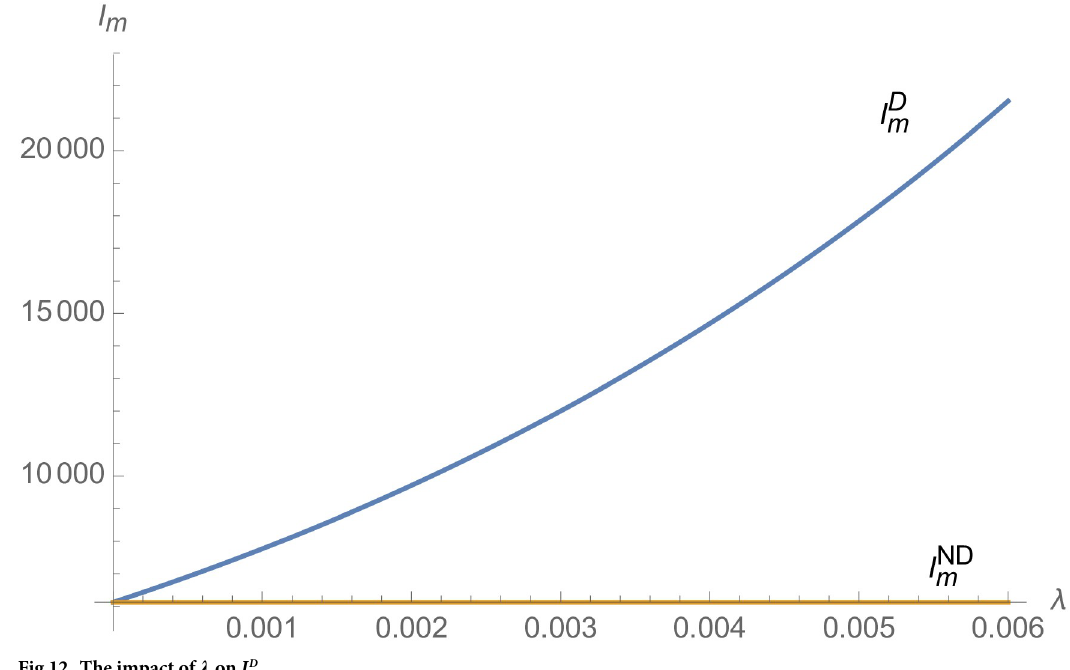
Fig 12. The impact of λ on I D